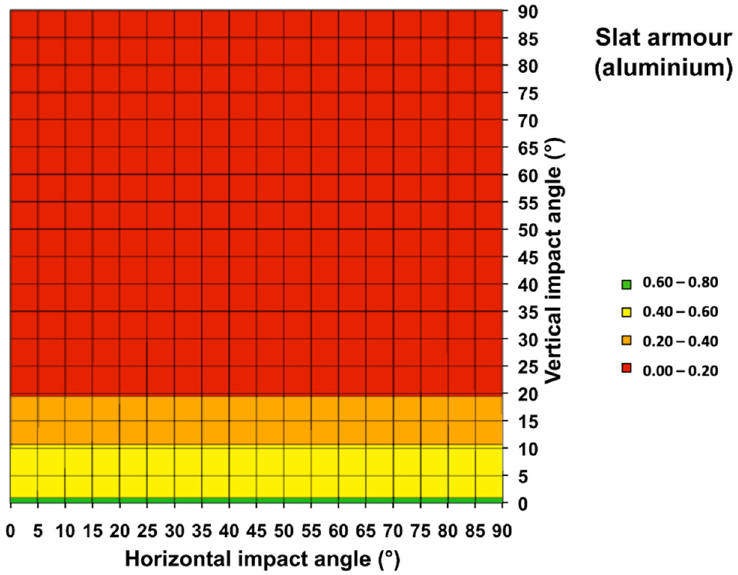
Figure 18. Efficiency of an aluminium slat cage armour solution as a function of the horizontal and vertical impact angle.